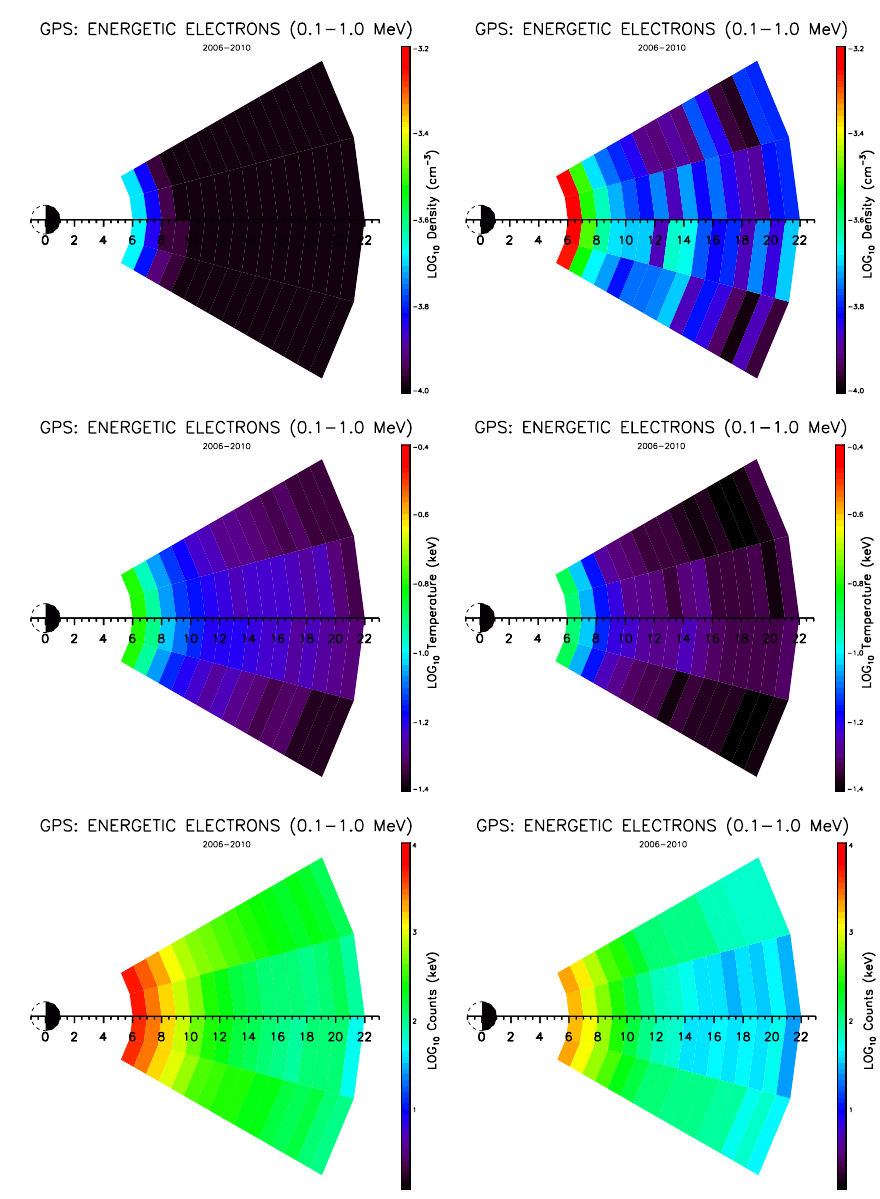
Fig. 4. Plots of the averaged energetic electron density ( N : top row), temperature ( T : middle row) and counts (bottom row) derived from measurements by GPS spacecraft at high-latitude and then mapped to the equatorial plane using the Tsyganenko T89 model as a function of LT and L for slow solar wind (left column: V SW = 100–400kms − 1 : 58857 data points) and fast solar wind (right column: V SW = 500– 1000kms − 1 : 23087 data